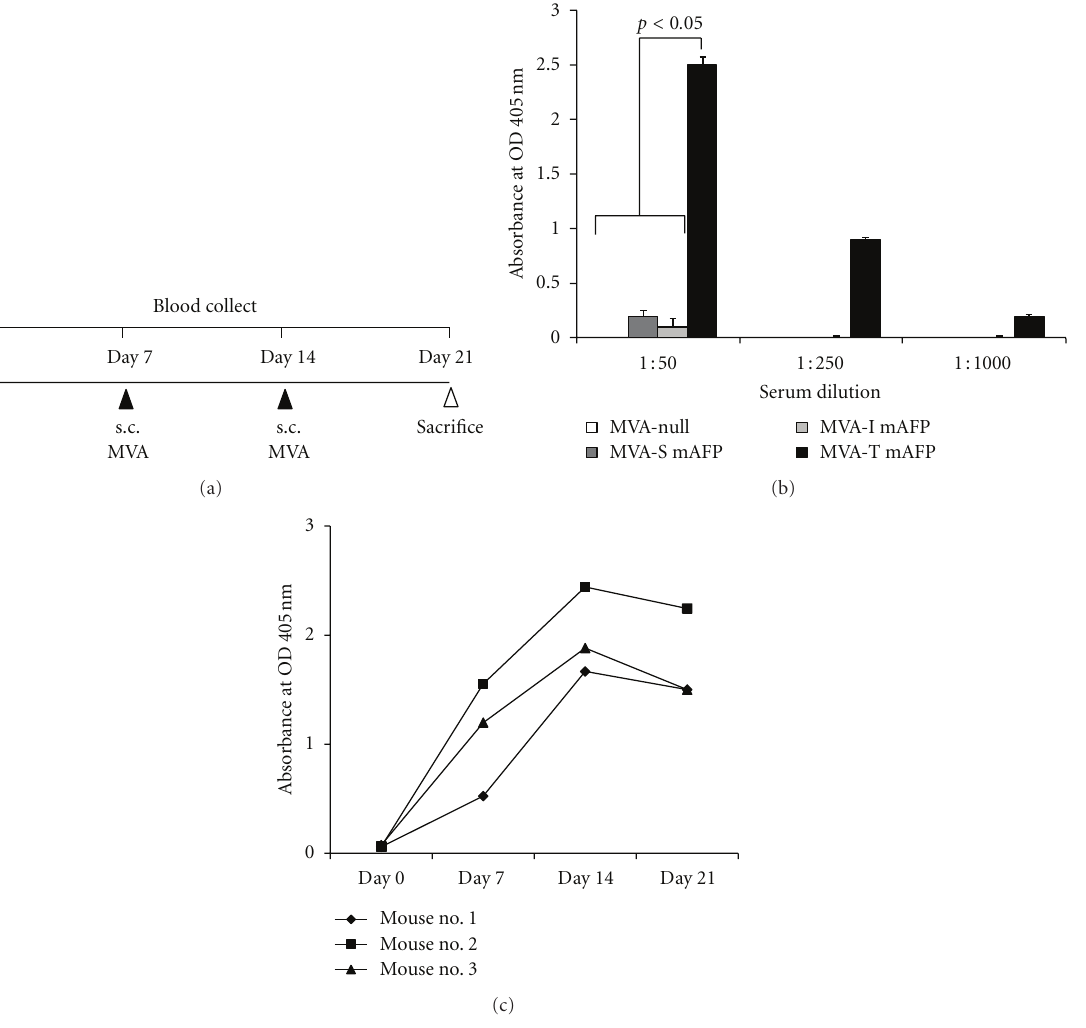
Figure 4: Induction of AFP-specific antibodies after vaccination with MVA-T mAFP. (a) Schematic of the experimental design. (b) ELISA analysis of sera from mice vaccinated with MVA-null, MVA-s mAFP, MVA-I mAFP, or MVA-T mAFP. Mean absorbances are determined at dilutions 1:50, 1:250, and 1:1000. (c) Time course of AFP-specific antibodies titre in sera from mice ( n = 3) vaccinated with MVA-T mAFP. The absorbance is determined for a 1 :50